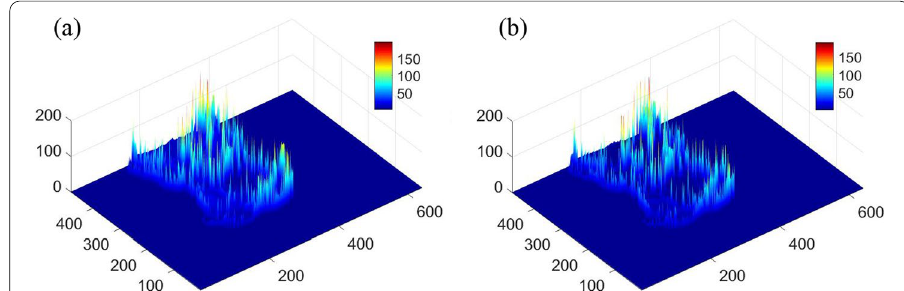
Fig. 4 Measurement error of different networks: a UNet; b the proposed network